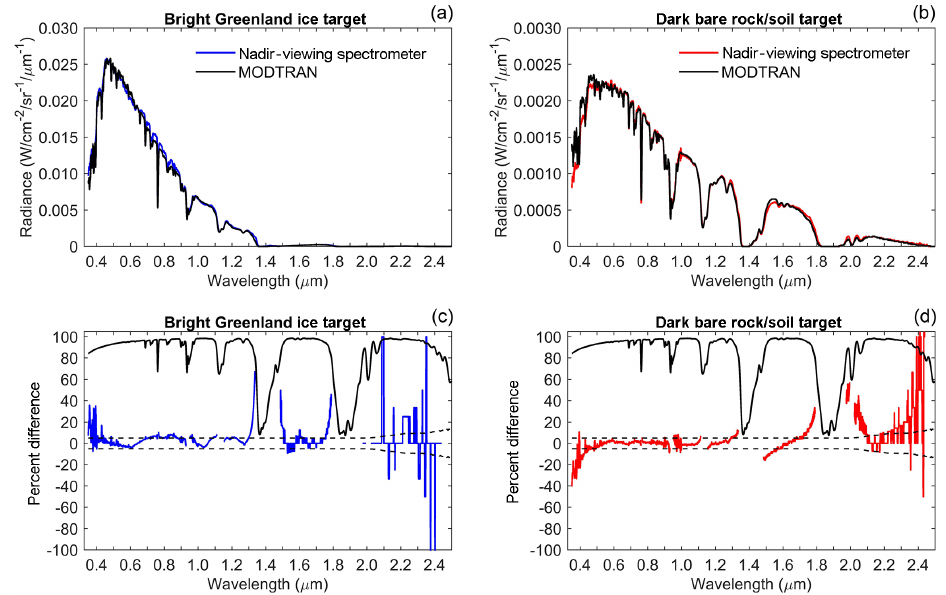
Figure 12. The airborne nadir-viewing spectrometer’s measurement performance for bright and dark targets as compared against MOD- TRAN. Panel (a) shows a comparison between predicted and measured radiance for bright Greenland ice. Panel (b) shows a predicted verse measured comparison for dark bare rock/soil. Panel (c) describes the percent difference, i.e., percent difference = (measured– predicted) / predicted, between predicted and measured nadir-viewing spectrometer radiance for bright Greenland ice (blue line). The percent difference for the dark bare rock/soil target is shown in panel (c) . The dotted and top thick black lines on panels (c) and (d) signify the mea- surement requirement and predicted atmospheric transmittance, respectively. The nadir-viewing spectrometer’s measurement performance beyond 2.0µm is subject to noise created by UC-12B BK-7 window transmission, and low to relatively low SWIR radiances for both bright and dark